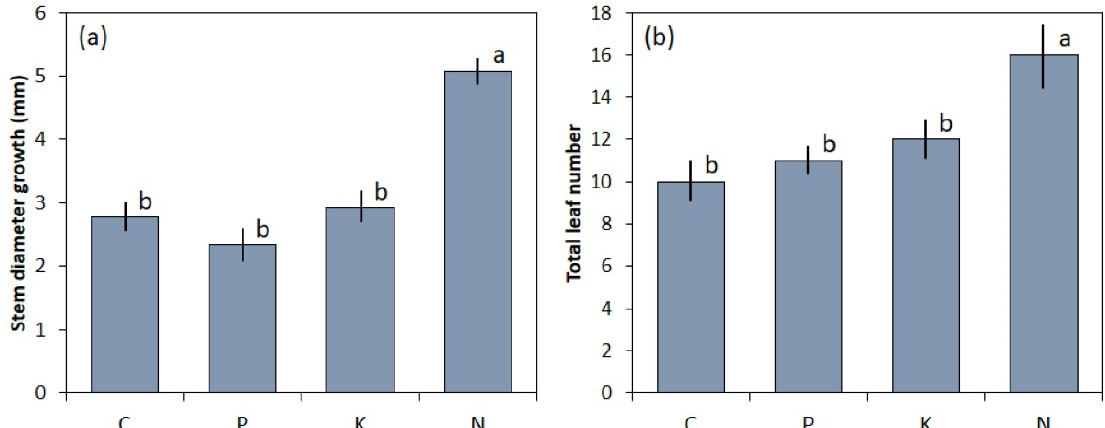
Figure 3. Growth of Serianthes nelsonii and Serianthes grandiflora plants (mean) influenced by phosphorus (P), potassium (K), or nitrogen (N) fertilization in relation to control (C) plants. ( a ) Stem diameter; ( b ) leaf number. Means ± standard error, n = 12. Bars with same letters are not different. Table 3. The influence of N, P, or K fertilization on nitrogen and phosphorus concentrations (mg · g − 1 ) of Serianthes nelsonii and Serianthes grandiflora leaves. C = control; P = phosphorus fertilization; K = potassium fertilization; N = nitrogen fertilization. Mean ± SE, n = 6.